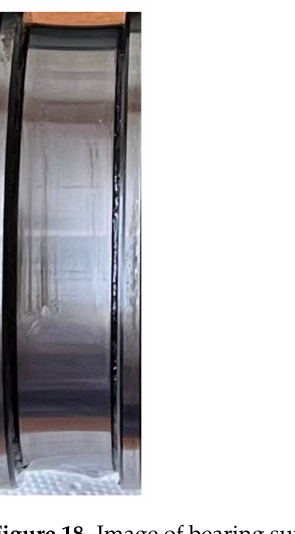
Figure 18. Image of bearing surface inner